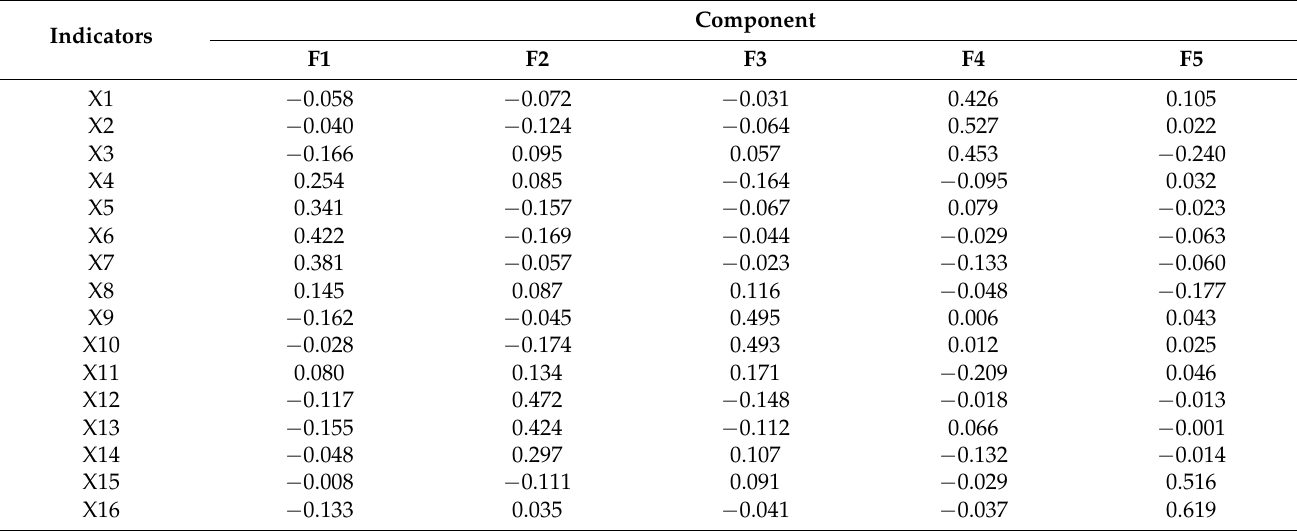
Table A4. Rotated component score coefficient